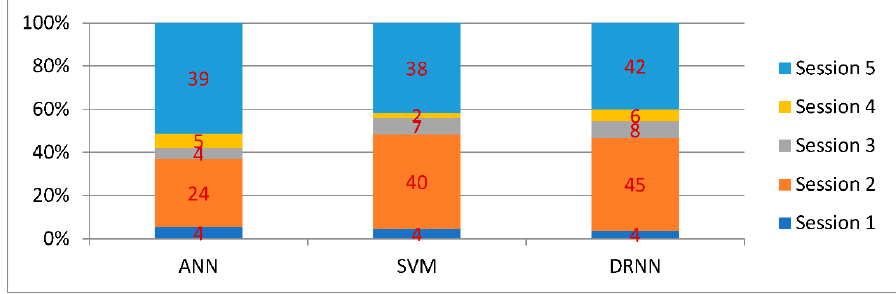
Table 3. Prediction performance under varying sessions. Figure 8. Comparative analysis between existing and proposed classification techniques for varying sessions.